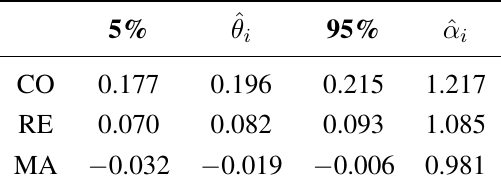
Table 7. Tail regression results for the exponential model of covariates, X = ( X (residential), CO (commercial), and MA (manfacturing). The corresponding estimated loadings are indicated by ˆ θ = (ˆ θ fraction corresponds to 10% of the largest losses in the entire dataset. We set ˆ α for the tail index estimate resulting from considering only the loading estimate ˆ θ to each individual occupancy type.